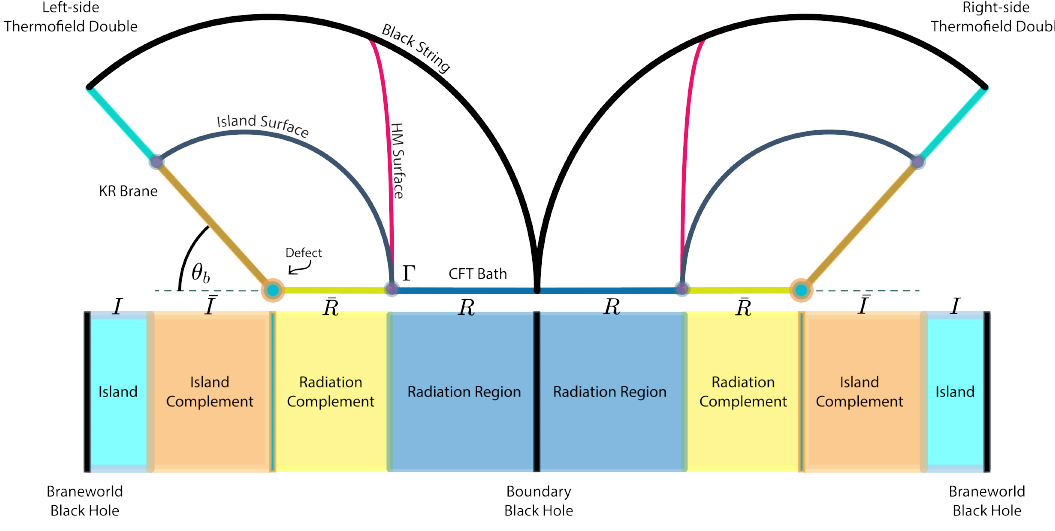
Figure 1 . This cartoon illustrates the doubly holographic black-string model, where the region behind the KR brane has been excised. There are three perspectives, with the AdS bulk illustrated at the top of the diagram. The d -dimensional BCFT and d -dimensional AdS are depicted in colors which correspond with the intermediate picture indicated at the bottom of the diagram. Notice the island region envelops the black-hole horizon on the brane, and the defect cannot be reached from the island in the intermediate picture without crossing through its complement. The two parameters in the theory are the anchor point Γ and brane angle θ that “left/right” has a different meaning than in our previous paper